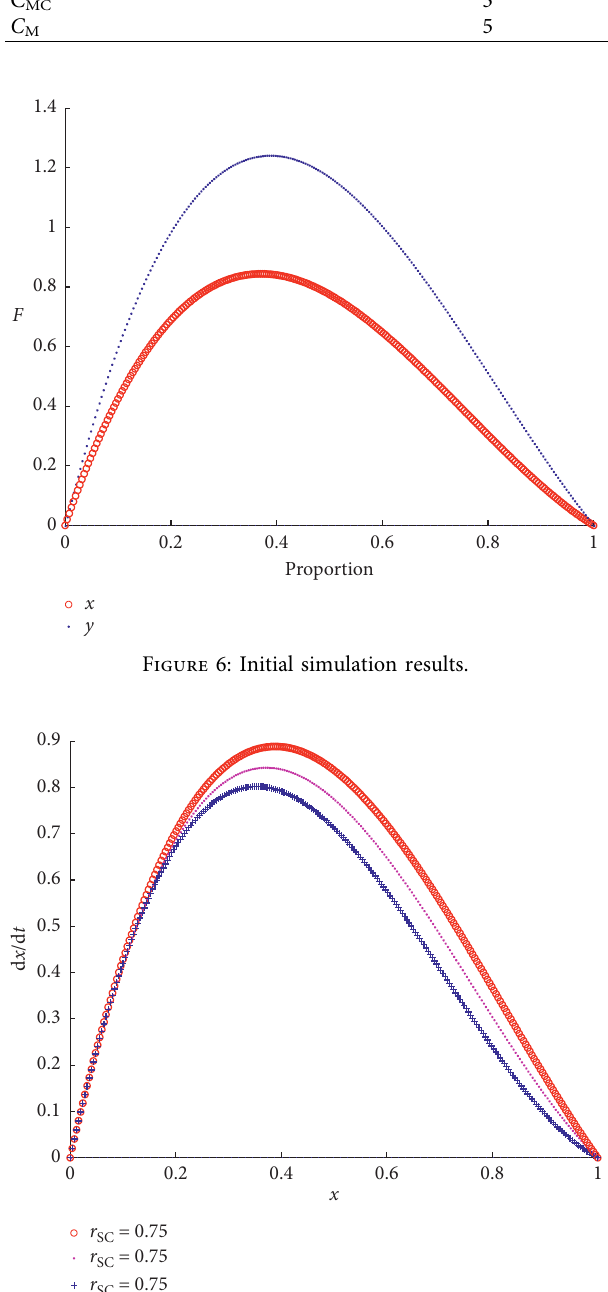
Figure 7: Analysis of simulation test results